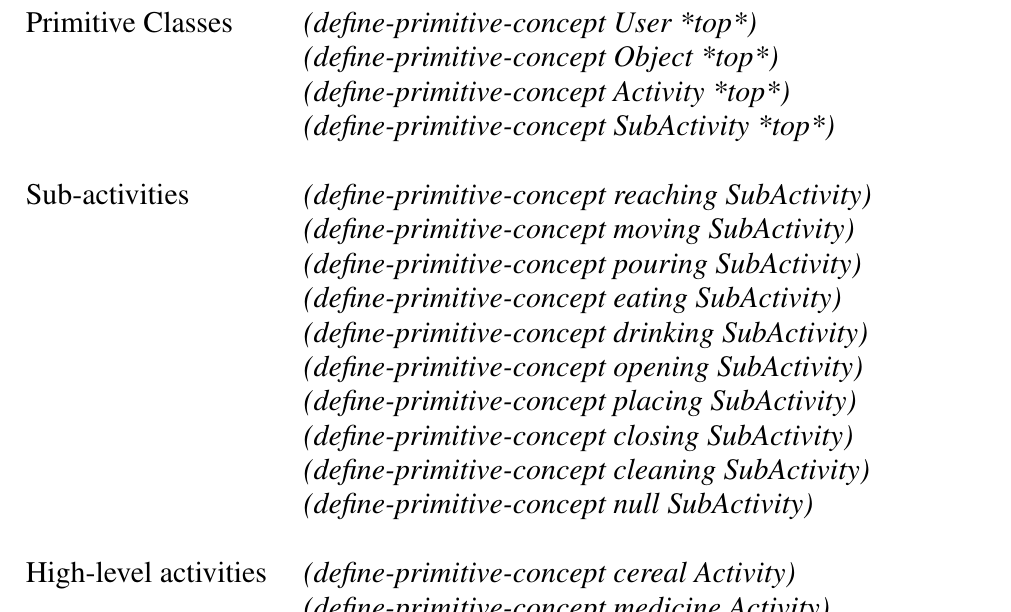
Table 4. Fuzzy concept